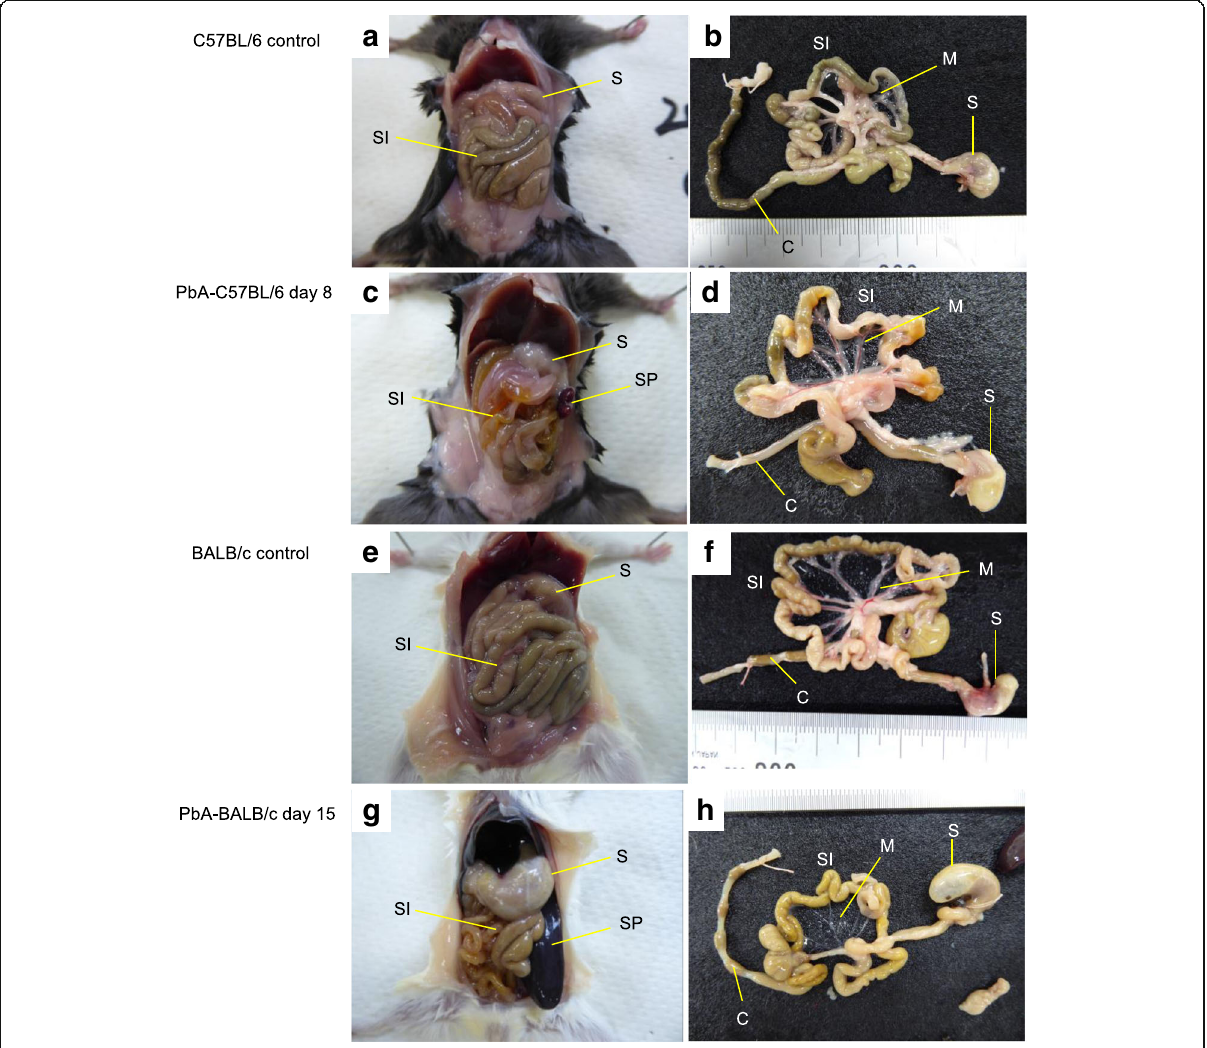
Fig. 3 Mouse abdominal gross pathology. A PbA-C57BL/6 mouse on day 8 and a PbA-BALB/c mouse on day 15 are shown with uninfected controls. a Macroscopic examination of the peritoneal cavity of an uninfected C57BL/6 mouse, showing the stomach and small intestine. b The stomach, small intestine, mesentery, and colon after removal from the mouse shown in a , c Macroscopic examination of the peritoneal cavity of a PbA-C57BL/6 mouse revealed a change in the course of the small intestine, and the spleen started to enlarge. d The gastrointestinal tract after removal from the mouse shown in c , with an edematous small intestine with reduced intestinal content and a colon containing only a small amount of retained faces. e Macroscopic examination of the peritoneal cavity of an uninfected BALB/c mouse. f The gastrointestinal tract after removal from the mouse shown in e , g Macroscopic observation of the peritoneal cavity of a PbA-BALB/c mouse revealed splenomegaly, dilatation of the stomach, and a change in the course of the small intestine. h The gastrointestinal tract after removal from the mouse shown in g , with a thinned, fragile mesentery. C colon, M mesentery, S stomach, SI small intestine, SP